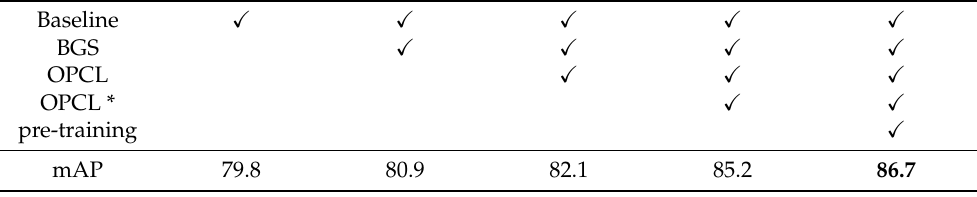
Table 9. The performance of RetinaNet sequentially adding our proposed modules. All experiments adopt ResNet50 as a backbone with the image scale of [600, 1000]. The symbol “*” means the gradient of OPCL with respect to IoU was computed during